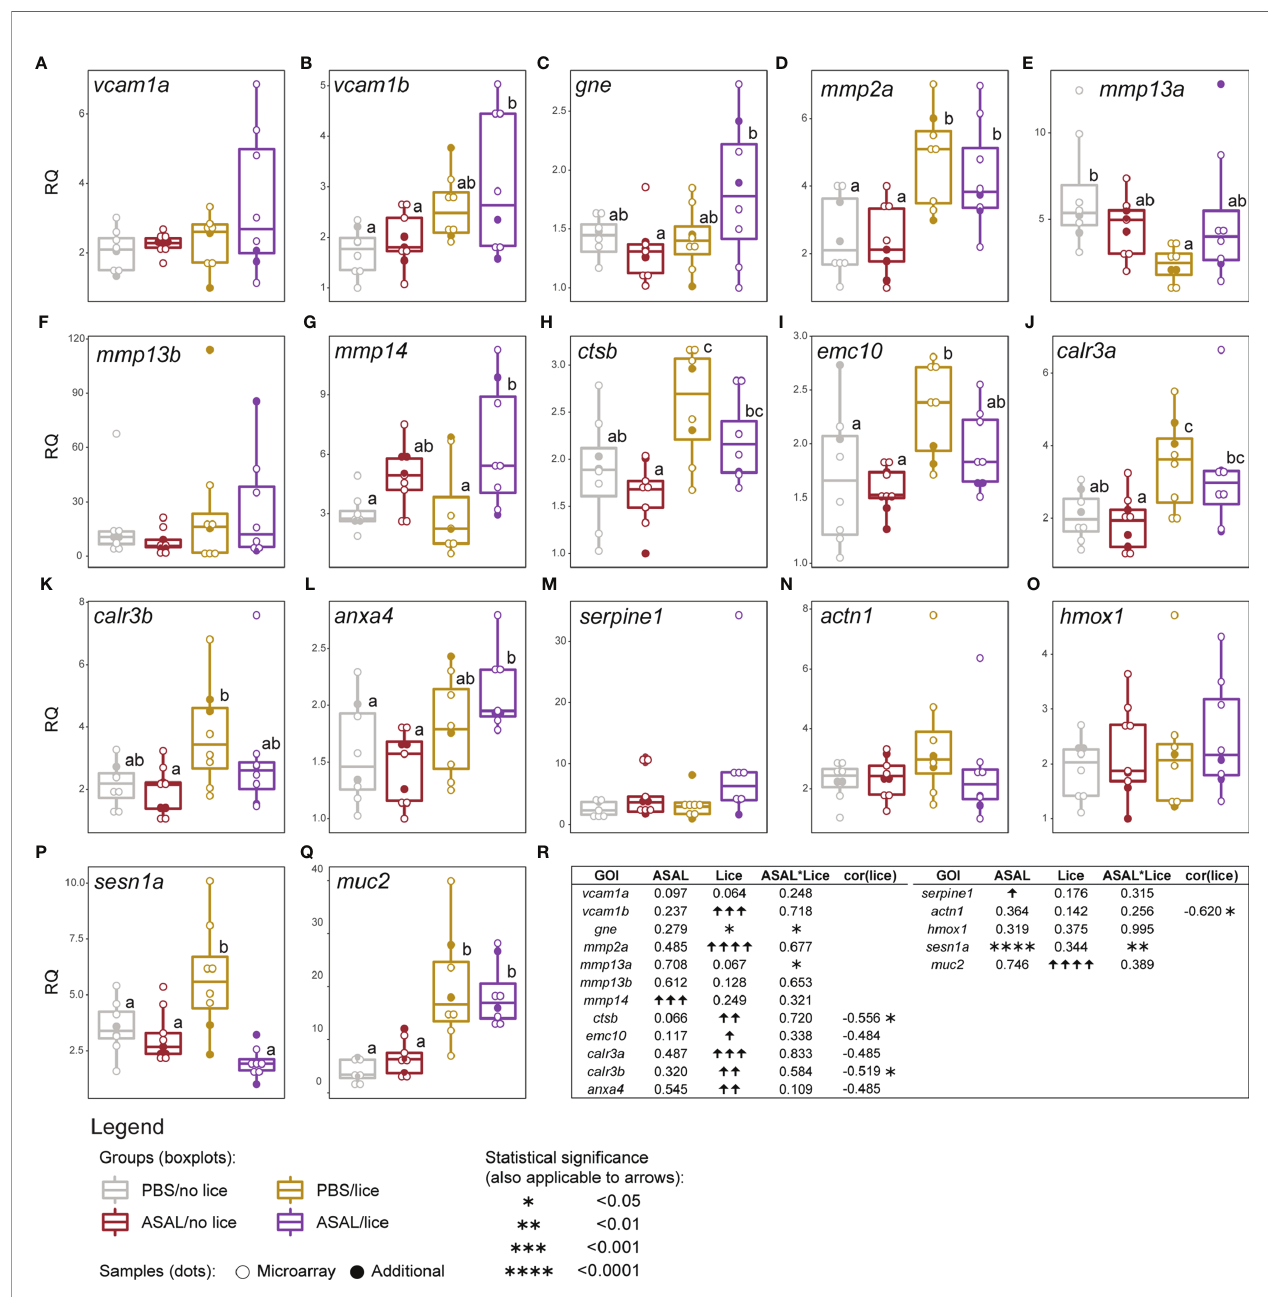
FIGURE 8 | qPCR results of lice, ASAL, and lice+ASAL-responsive genes putatively involved in (A – C) cell adhesion, (D – L) tissue remodeling and development, (M, N) hemostasis and platelet activation, (O, P) heme degradation and protection against oxidative stress, and (Q) constitution of the mucosal barrier. qPCR data are represented with scatter plot and boxplot overlays (n = 8-9 per injection/infection group). The scatter plot differentiates the additional biological replicates included in the qPCR validation (solid dots) from those selected for microarray analysis (empty dots). Lowercase letters indicate signi fi cant differences between groups, as determined by estimated marginal means. (R) Summary of the results from the generalized linear model (GLM) analysis of the qPCR data, and the Pearson correlation analysis of gene transcript levels and total lice counts. Upward and downward arrows indicate signi fi cant up and down-regulation, respectively. Asterisks are used instead of arrows when signi fi cant lice and ASAL interaction (i.e., lice*ASAL) was detected. Asterisks also indicate signi fi cant Pearson correlation. The statistical signi fi cance threshold was p < 0.05 for all statistical analyses. emc10 ’ s, calr3a ’ s, and anxa4 ’ s Pearson coef fi cients are indicated due to their closeness to statistical signi fi cance (i.e., 0.05 < p < 0.10) and physiological